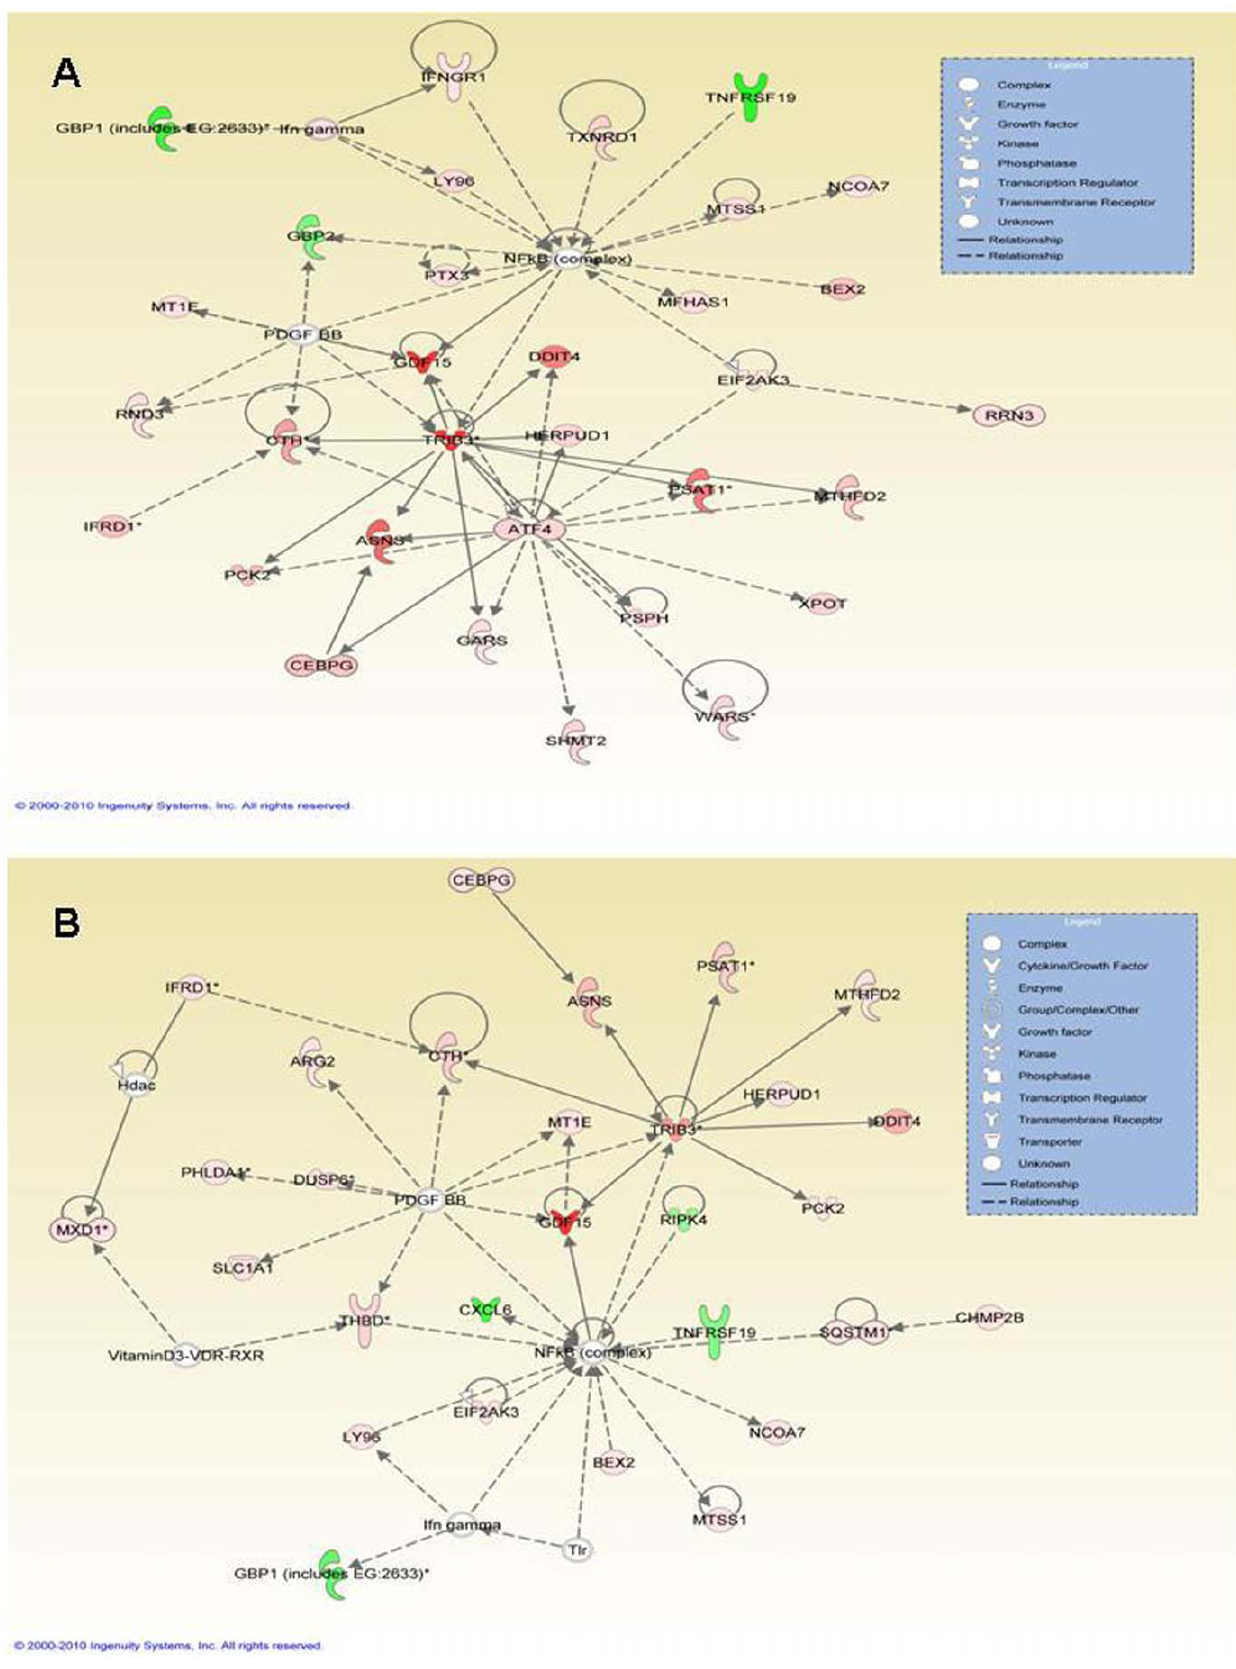
Figure 3. Functionally related gene networks constructed from the (A) normal untreated vs normal rottlerin-treated comparison or (B) SSc untreated vs SSc rottlerin-treated comparison. Differentially expressed genes for each comparison were entered into Ingenuity Pathwork Analysis (IPA) software v 5.0. Nodes represent genes, with their shape representative of the functional classification of the gene product as PLoS ONE |